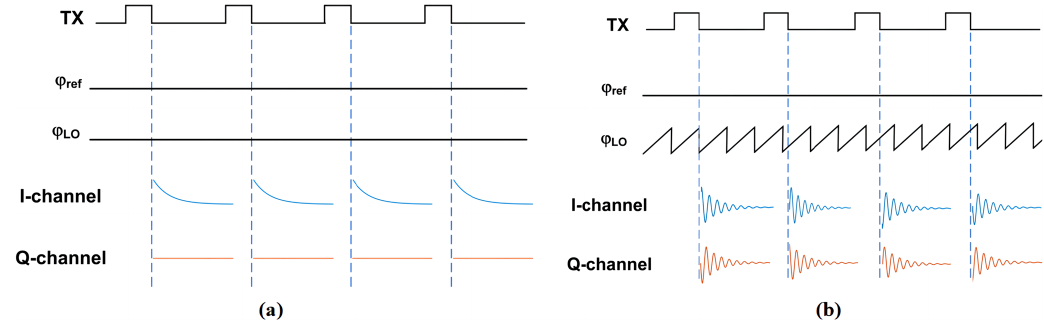
Figure 1. Illustration of the effect of the choice of the receiver LO frequency on the phase of the down-converted NMR signal. (a) Homodyne detection and (b) low-IF